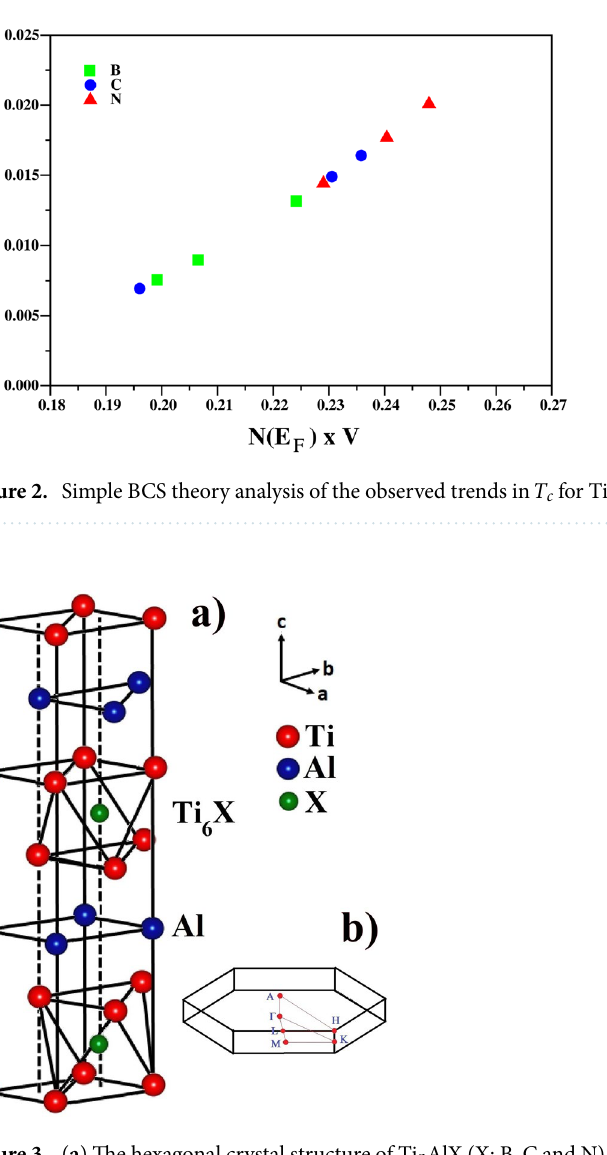
Figure 3. ( a ) The hexagonal crystal structure of Ti 2 AlX (X: B, C and N) , where blocks of Ti-X (X: B, C and N) (formed by edge-shared Ti 6 X (X: B, C and N) octahedra) are sandwiched with Al atomic sheets. ( b ) The hexagonal Brillouin zone for Ti 2 AlX (X: B, C and